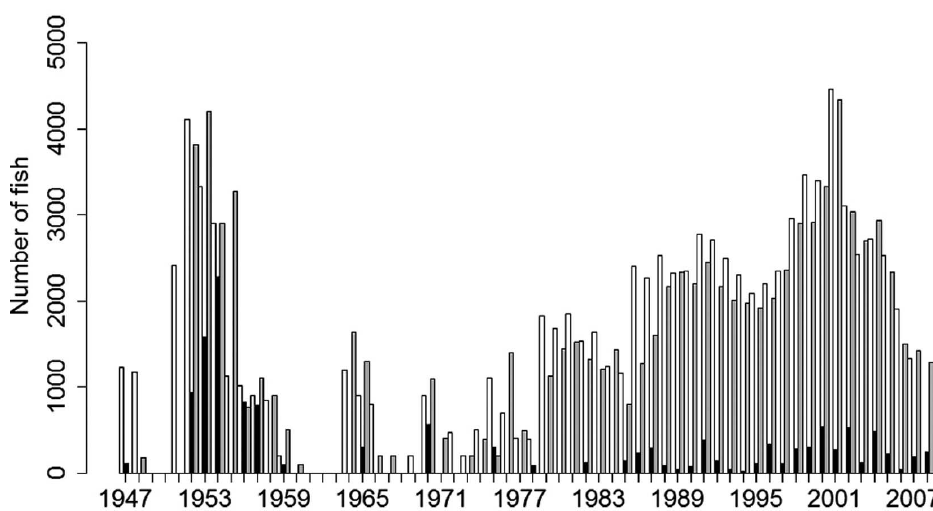
Fig . 3. – Total number of individuals (white bars) and number of first-year spawners (black bars) sampled per spawning season (October to March) and total number of individuals sampled per growing season (grey bars) in the period